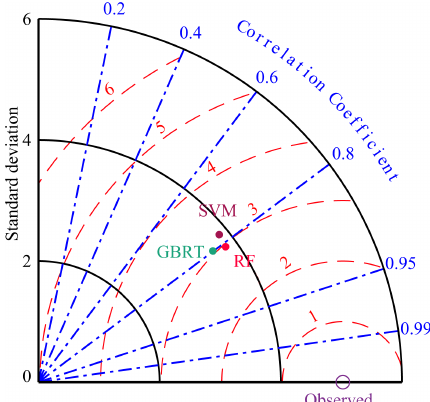
Figure 5. A Taylor diagram used to evaluate the model performance of random forest (RF), support vector machine (SVM), and gradient boosting regression tree (GBRT) models, which were used to pre- dict the SOCS in the upper 30cm of soil profiles across the Third Pole. The contour centered on the observed indicates the root-mean- square error (RMSE, kg m − 2 ) between the predicted value and ob- served